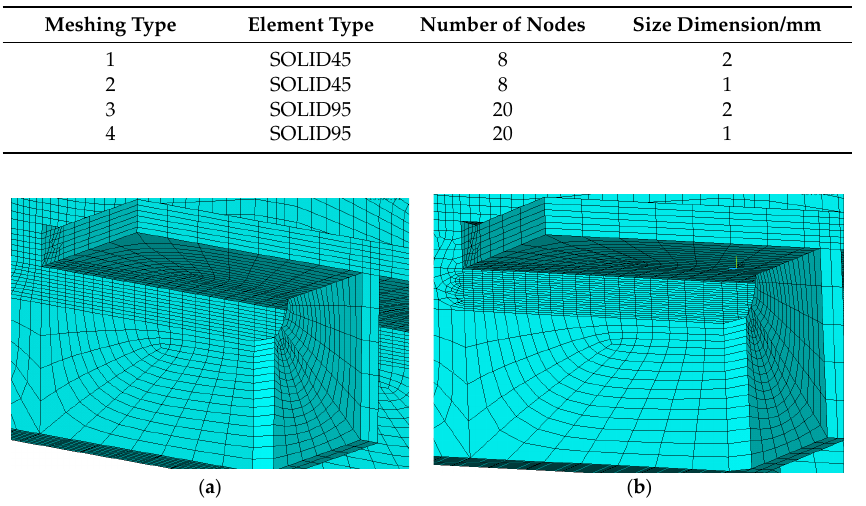
Table 3. Different meshing types.